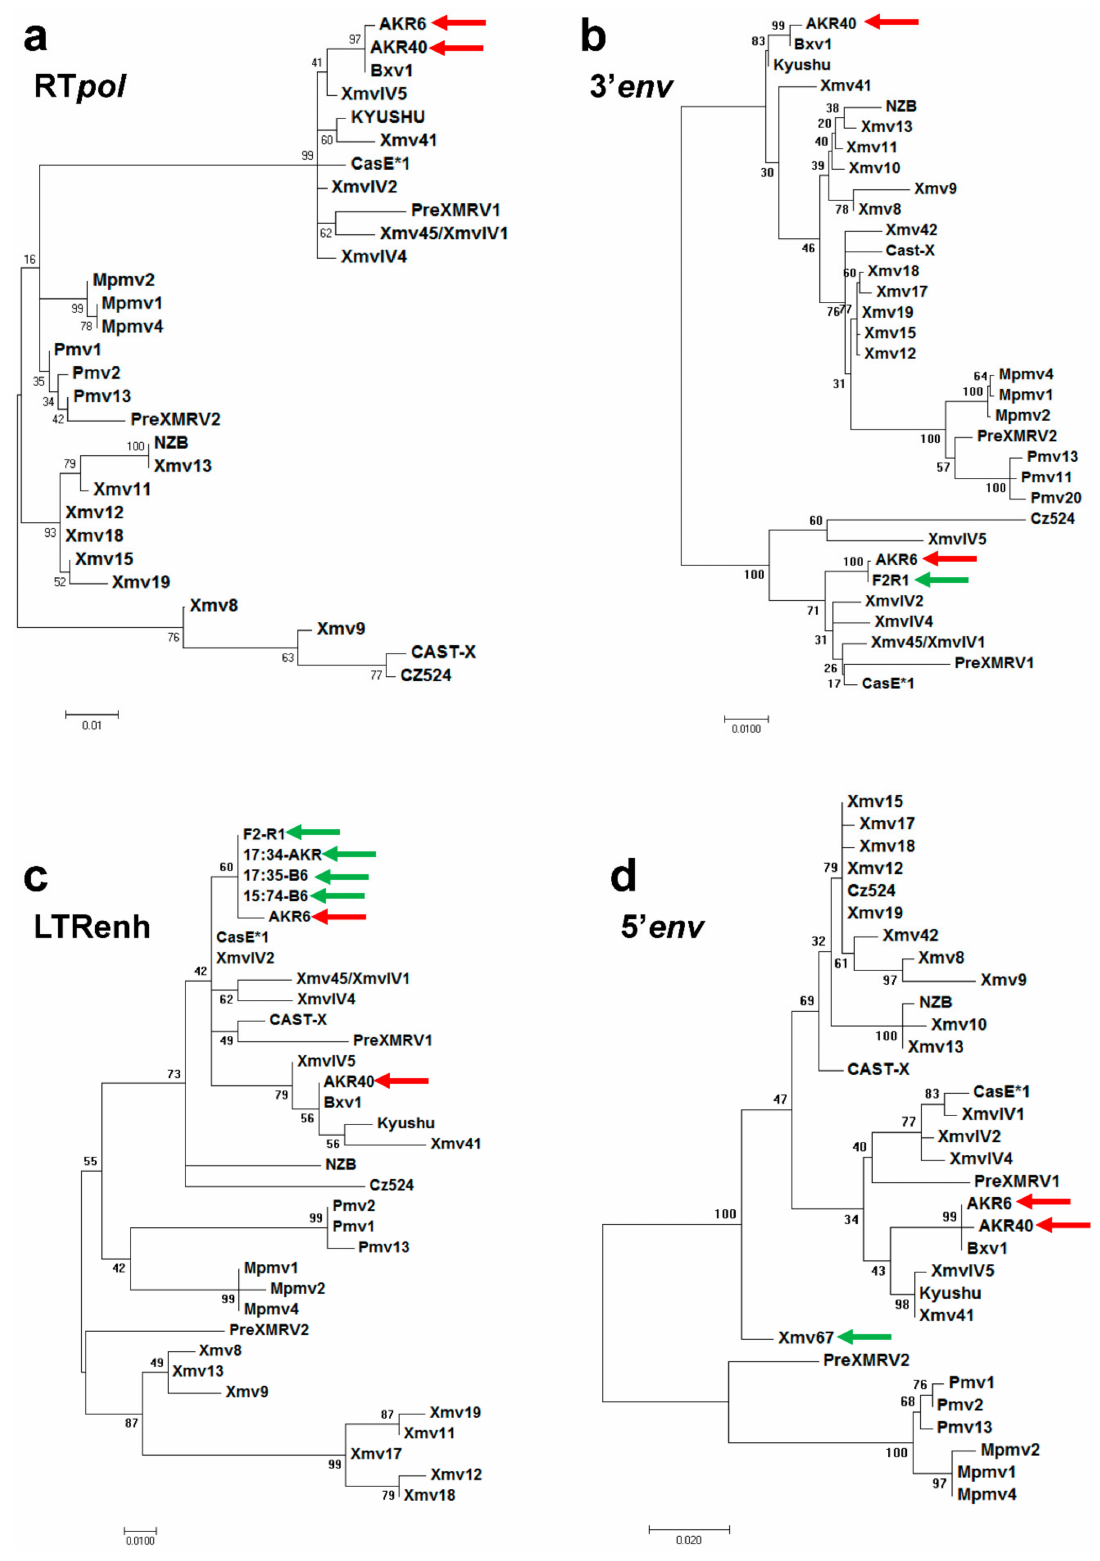
Figure 2. Phylogenetic trees of four domains of the MLV genome. ( a ) RT pol , ( b , c ) the env and U3-LTR enhancer substitutions in AKR6, ( d ) the 5’ VRA-containing end of env . The percentage of trees in which the associated taxa clustered together is shown next to the branches. The trees are drawn to scale, with the branch lengths measured in the number of substitutions per site. Red arrows identify AKR40 and AKR6 MLVs, and green arrows identify AKR6-related PCR products or mined sequences from the AKR/J genome. All of the Xmvs , Pmvs , and Mpmvs are from the B6 reference